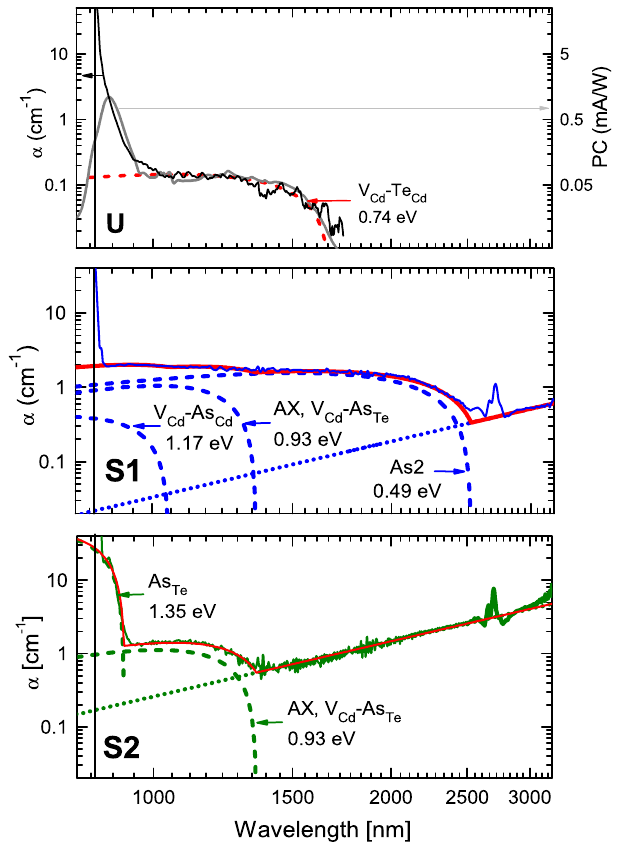
Figure 1. Absorption (left axis; black, blue, and green solid slides) and photoconductivity (right axis; grey solid line) spectra for undoped (U) and As-doped (S1, S2) single-crystal CdTe. E g = 1.51 eV was assumed and is shown as a solid vertical line. Absorption coefficient error is 0.05 cm −1 . Dashed lines approximate photoionization fits for traps, while dotted lines indicate free carrier absorption. Sharp peaks at ~ 2700 nm are measurement artifacts. Tentative peak assignments to electronic defect states are